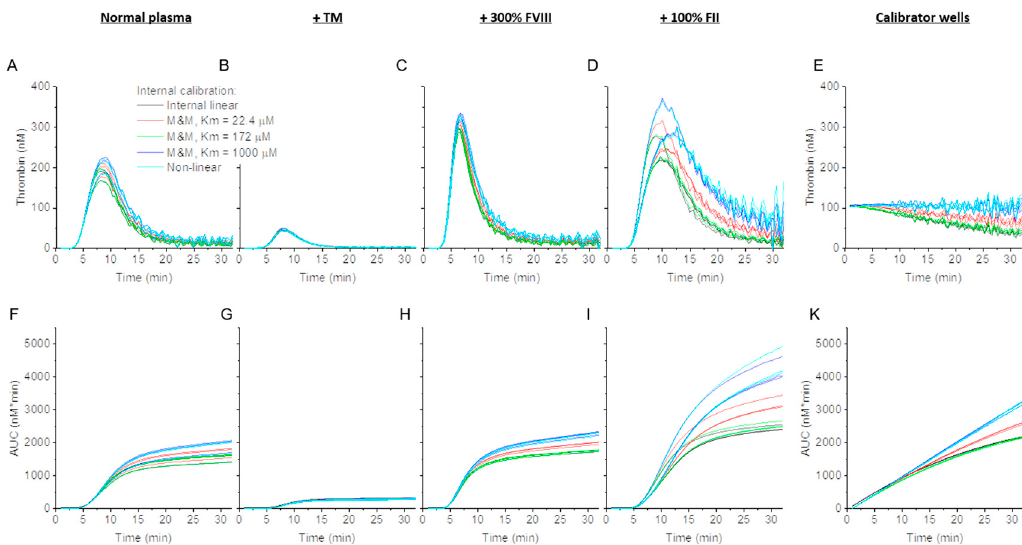
Figure 2. TG after internal linear, internal non-linear, and internal Michaelis–Menten (M&M) calibration in normal plasma supplemented with coagulation factor (F) II, FVIII, or thrombomodulin (TM). Representative CAT experiment in PFP triggered with 1 pM TF calibrated with the indicated method: internal linear (black), internal non-linear (cyan), or internal M&M (red: Km = 22.4 µM [26], green: Km = 172 µM [14], and blue: Km = 1000 µM). ( A – E ) TG curves in normal plasma supplemented with TM, 300% FVIII and 100% FII. ( F – K ) Area under the curve (AUC) as a function of added coagulation factor level ( E , K ). Curves from calibrator wells.